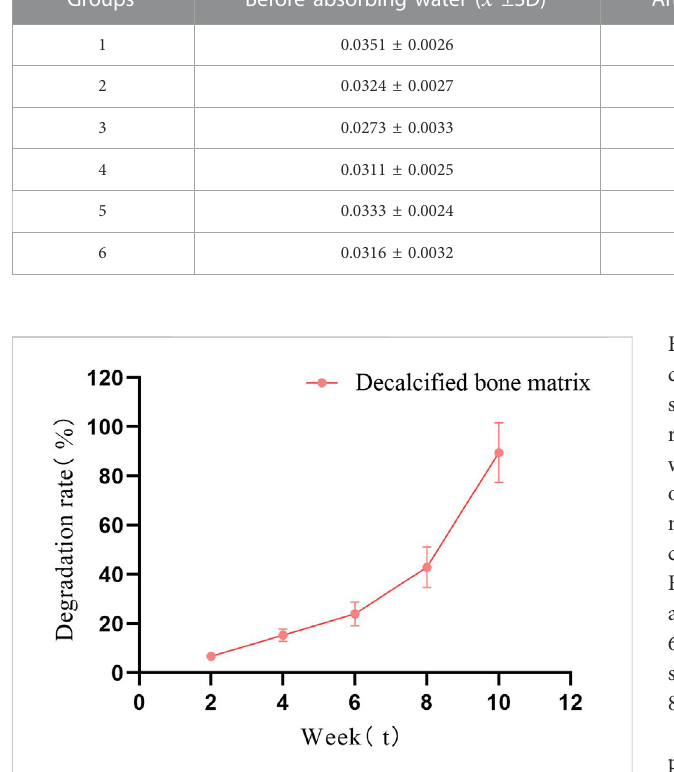
TABLE 1 Water absorption in each group (n = 3, per group). Groups